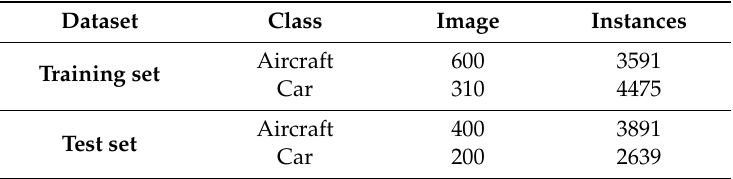
Table 8. UCS-AOD dataset